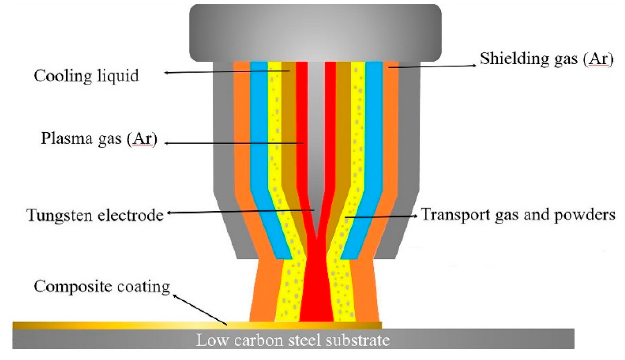
Figure 2. Schematic diagram of plasma spray welding.